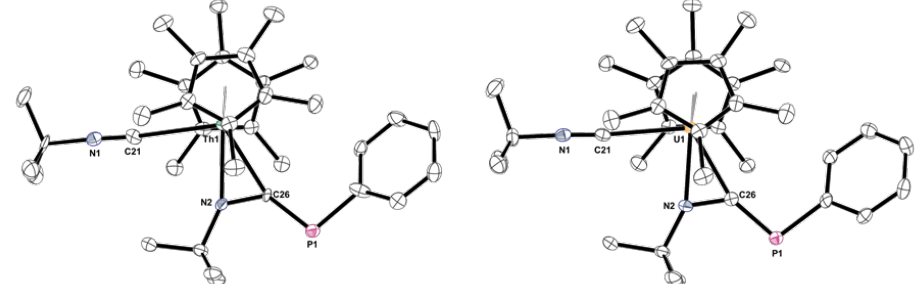
Figure 2. Thermal ellipsoid plots of 3 (left) and 4 (right) shown at the 50% probability level. Hydrogen atoms have been omitted for clarity. Table 1. Selected bond distances (Å ) and angles in 3 and 4 with comparison to the previously